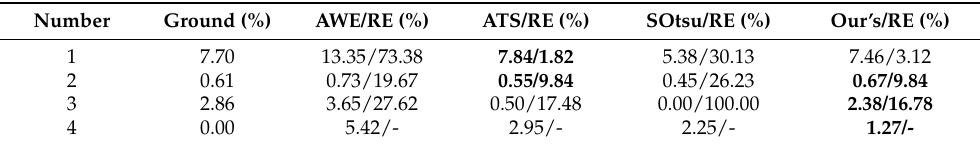
Figure 9. ( a ) Original images; ( b ) whitecap obtained using AWE; ( c ) whitecap obtained using ATS; ( d ) whitecap obtained using the sub-image Otsu method; and ( e ) whitecap obtained using the proposed method. Table 1. Comparison of W obtained by different methods; in each method column, the first data are W , and the second data are the relative error (RE) between the ground truth and obtained W . Text is bolded to indicate that the method performs best in this